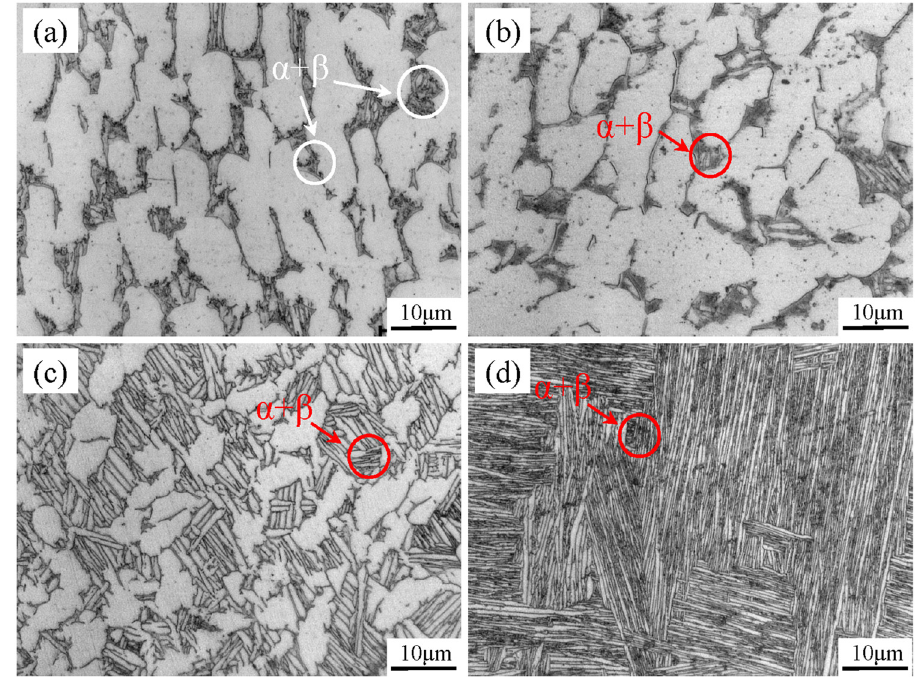
Figure 1: Metallographic images of Ti80 alloy: ( a ) as - forged, ( b ) 900°C × 1 h/AC, ( c ) 980°C × 1 h/AC, and ( d ) 1,020°C × 0.5